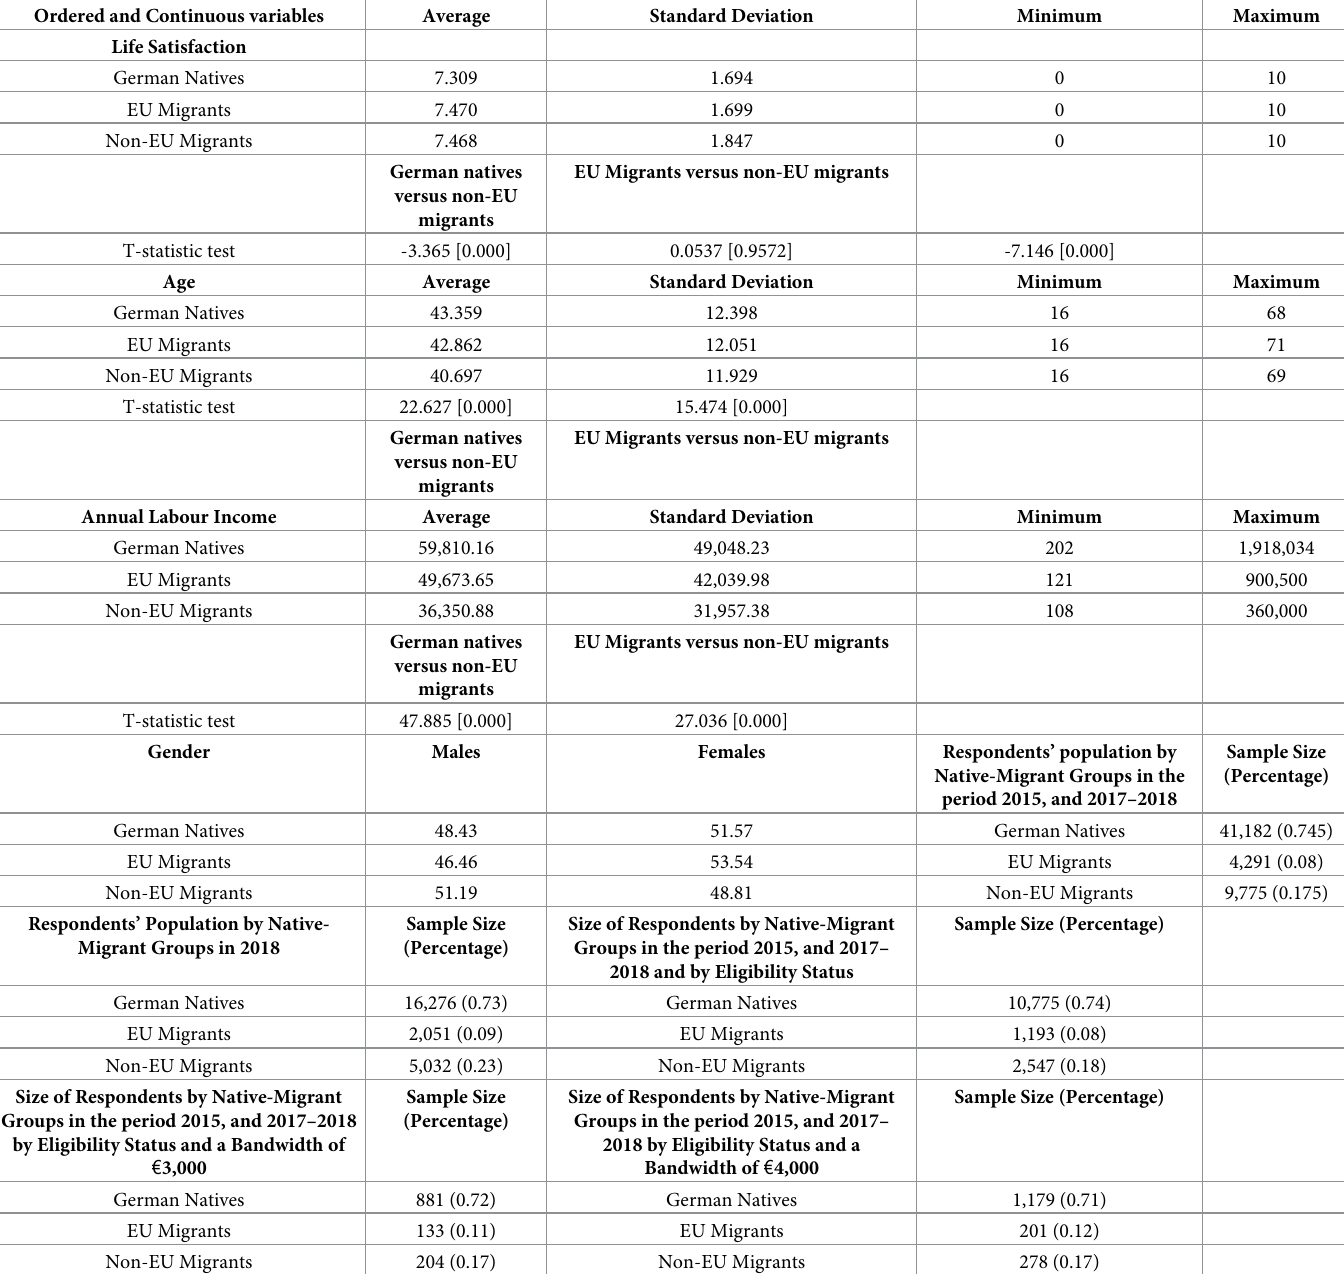
Table 3. Summary